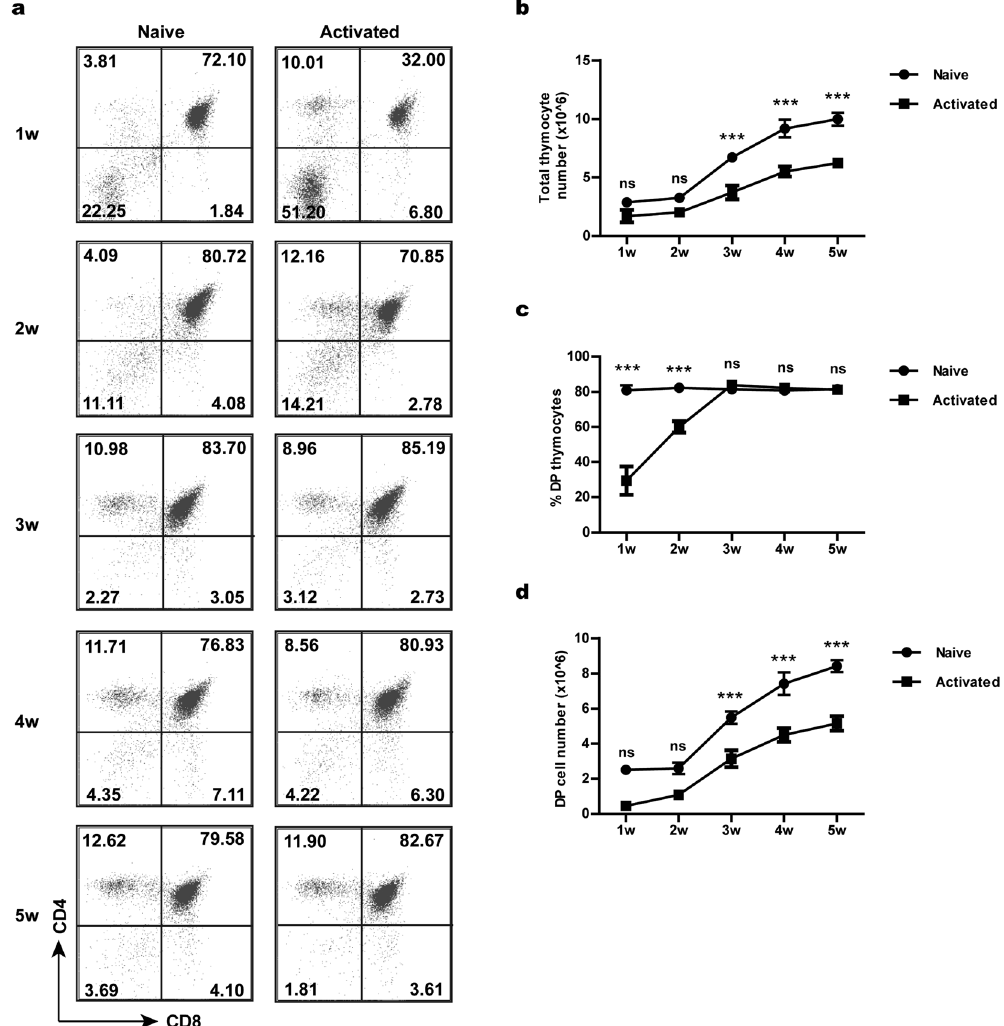
Figure 2. The impaired capacity of activated T cell-treated fetal thymuses to support T cell development in vivo . Fetal thymuses (CD45.2 + ) were first mixed with naive or activated T cells in hanging drops for 24 hours and then cultured in FTOC for 12 days before being implanted under the kidney capsules of CD45.1 + mice. The development of host T cells in the implants was analysed by flow cytometry. ( a ) Representative CD4/ CD8 staining profiles of CD45.1 + host-derived thymocytes at different time points after transplantation. The number indicates the percentage of cells in each quadrant. ( b ) Cell counts of host-derived thymocytes. ( c ) The percentage of DP thymocytes. ( d ) The absolute number of DP thymocytes. The experiments were repeated three times with at least 5 mice for each experiment. Data are presented as Mean ± SEM. * p < 0.05; ** p < 0.01; *** p < 0.001; and ns, not significant. In addition to the point-to-point comparisons shown in the figure, two- way Anova analysis was performed to determine the statistical significance of the differences between the two groups over the time course in terms of total thymocyte number (p < 0.0001), percentage of DP thymocytes (p < 0.0001) and absolute number of DP thymocytes (p <